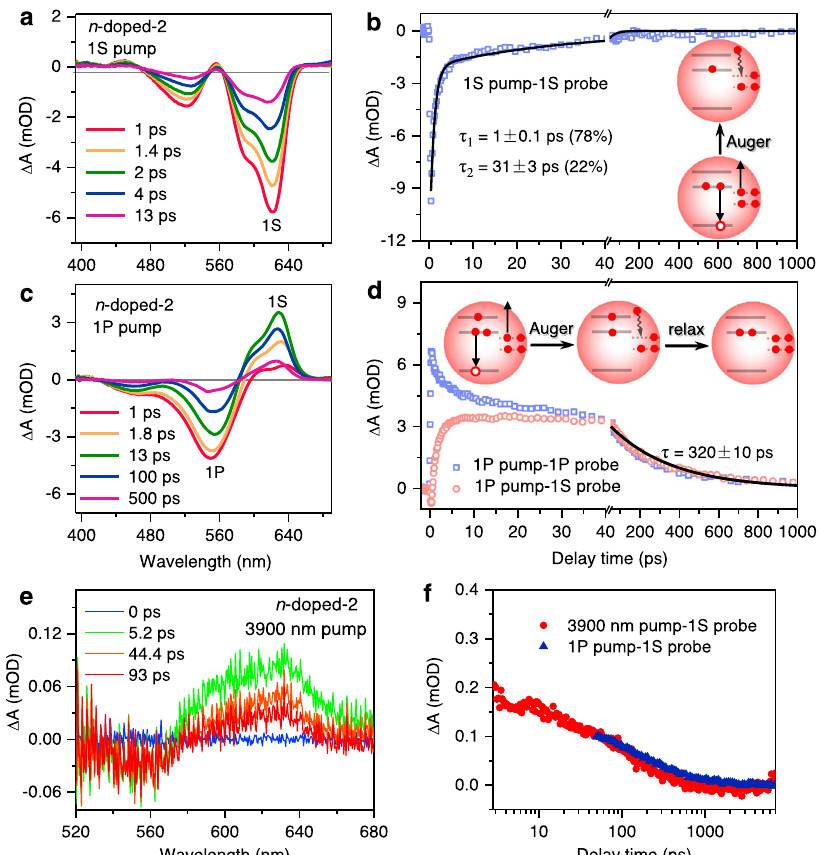
Fig. 5 Phonon bottleneck in heavily n -doped QDs. TA spectra of n -doped-2 probed at indicated time delays following excitations at a 1S e -1S 3/2,h and c 1P e -1P 3/2,h transitions by 624 and 547nm pulses, respectively. The 1S absorption and 1P bleach features are indicated in c . b TA kinetics probed at the 1S bleach for n -doped-2 under 1S e -1S 3/2,h excitation (blue square) and its bi-exponential fi t to time constants of 1 and 31ps (black line). The scheme on the right is a depiction of the trap- electron-assisted Auger recombination. Note that only QDs doped with one electron are shown because QDs doped with two or more electrons cannot absorb the 1S resonant pump photon. d TA kinetics probed at the 1S absorption (red circle) and 1P bleach (blue square; inversed and scaled) for n -doped-2 under 1P e -1P 3/2,h (547nm) excitation. Black solid lines are simultaneous fi ts of their slow relaxation components to a time constant of 320ps indicative of a phonon bottleneck. Inset is a schematic depiction of trap-electron-assisted Auger recombination followed by slow hot electron relaxation in heavily n -doped QDs. Only QDs with two doped electrons are shown in this scheme. In QDs doped with one electron, there is a competition between Auger recombination and spin- fl ip hot electron relaxation; see main text for details. e TA spectra at indicated delays of an n -doped-2 sample under 3900nm pump. f Comparison of TA kinetics probed at the 1S absorption feature under 3900nm pump (red circles) and 1P exciton pump (blue